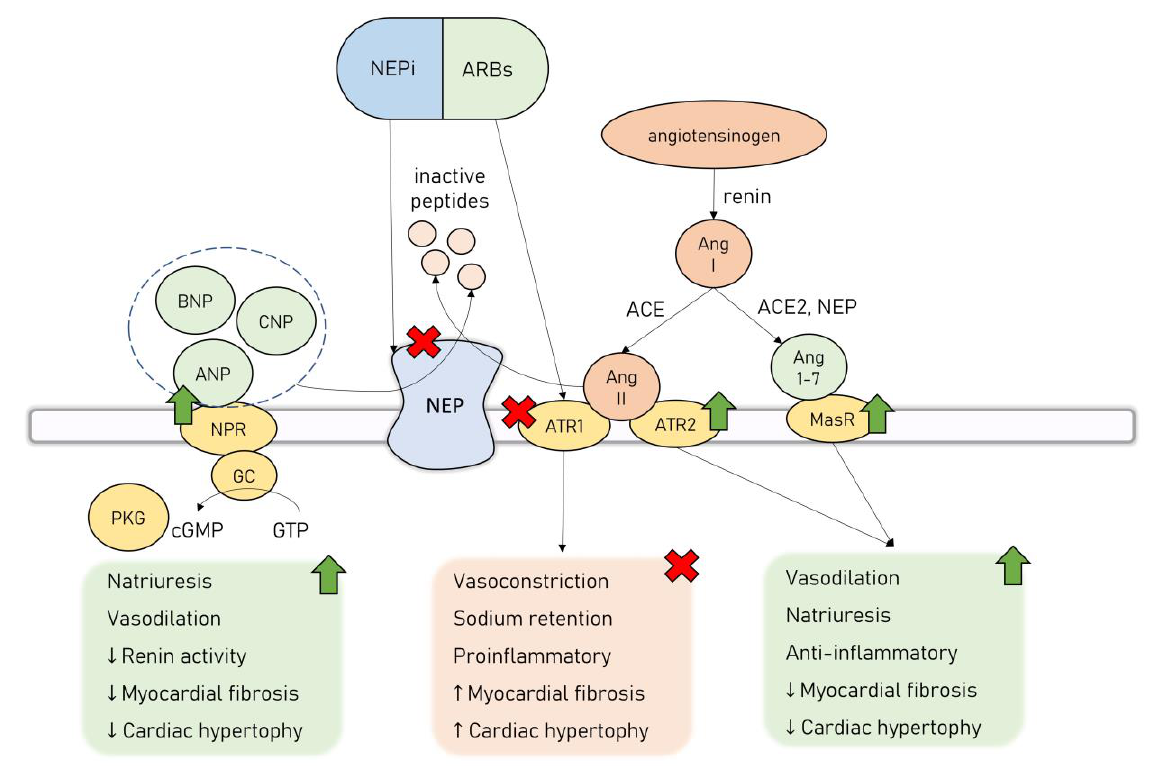
Figure 2. Dual neprilysin and angiotensin II receptor type 2 blockage by ARNi.